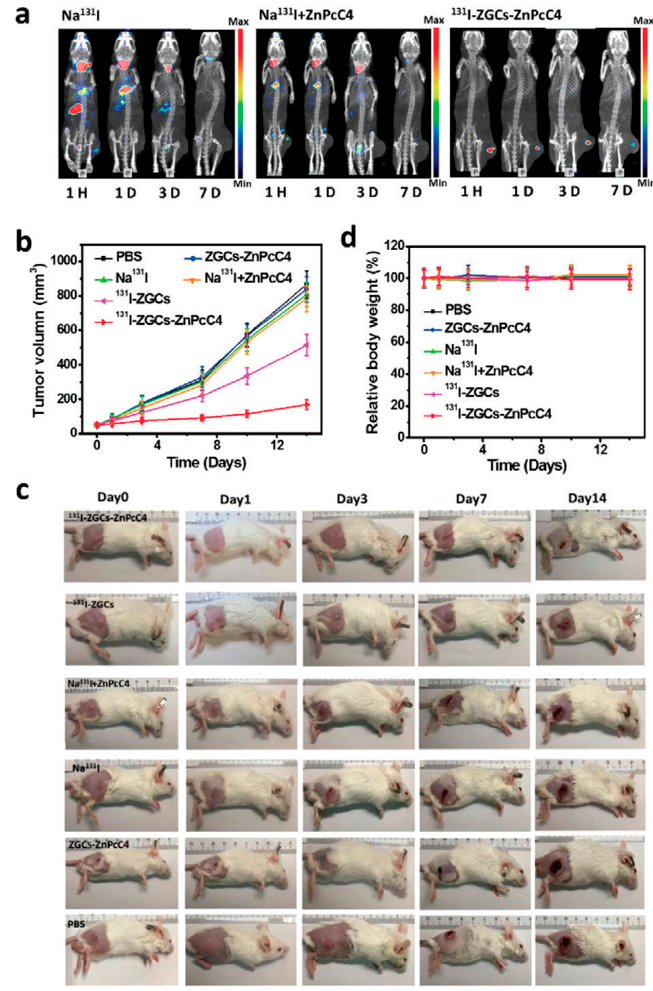
Figure 21. ( a ) SPECT / CT images of 4T1 tumor bearing mice treated with intratumoral injection of 100 µ Ci Na 131 I, 100 µ Ci Na 131 I + 20 100 µ g ZnPcC4, and 131 I-ZnGa 2 O 4 :Cr III –ZnPcC4 (100 μ Ci, 200 μ g). ( b ) Tumor growth curves as a function of time for di ff erent treatments. ( c ) Representative photographs for di ff erent ice with di ff erent treatments. ( d ) Body weight as a function of time for di ff erent treatments. Reproduced from [289] with permission from